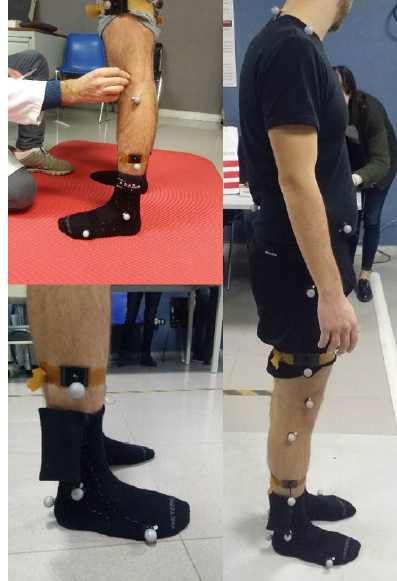
Figure 5. Subject equipped with both systems: SWEET Sock and reflective